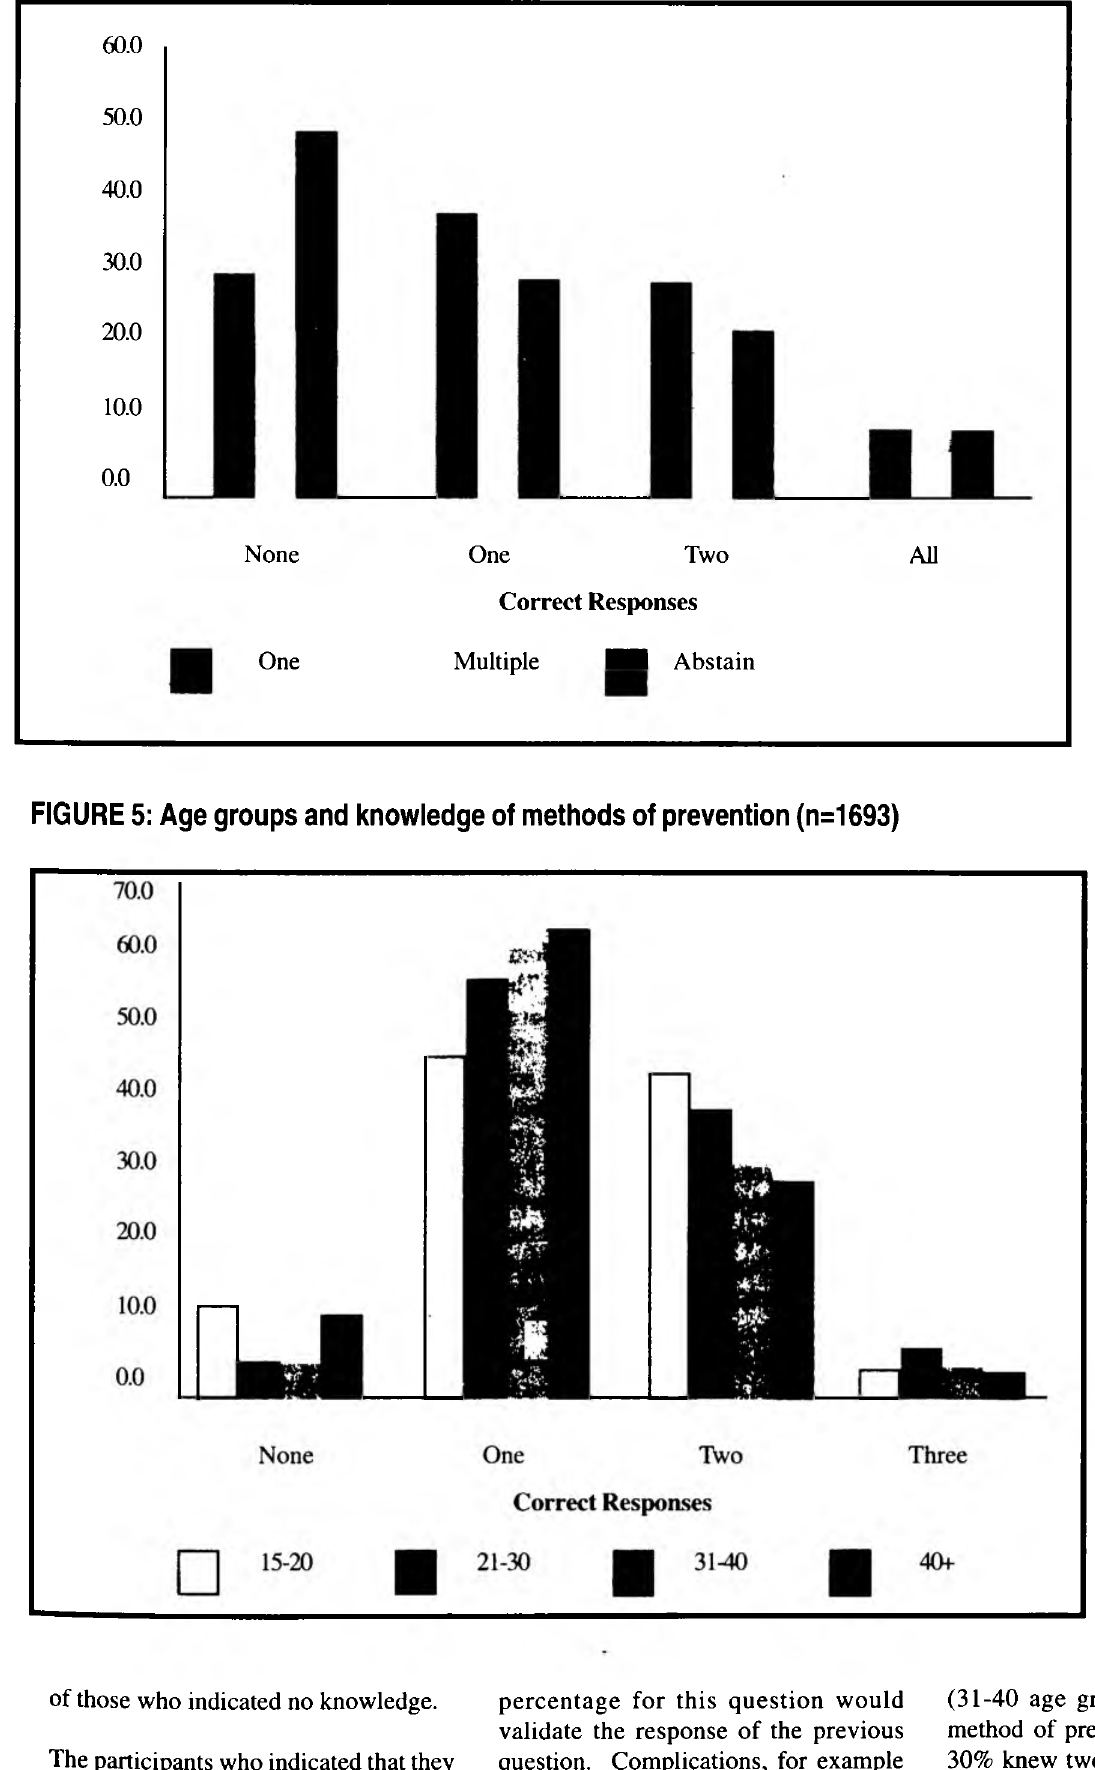
of those who indicated no